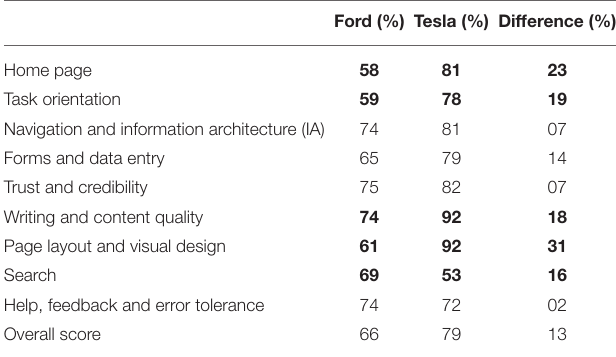
TABLE 6 | The final survey values (expressed in milliseconds) about reaction time expressed in milliseconds. Ford HP (Post-test)